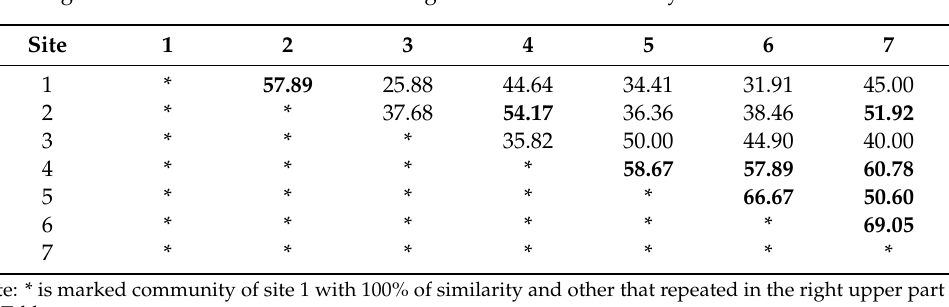
Figure 13. Canonical correspondence plots for algal communities in seven studied site of the Abraham Lincoln Birthplace National Historical Park at the division level and the environmental variables ( a ), and most abundant species, and environmental variables ( b ). Table 5. Similarity matrix for species richness of algae in the Abraham Lincoln Birthplace National Historical Park waterbodies. The abbreviations for the sites are the same as in Tables 1 and 2. The most similar algal communities with coe ffi cients larger than 50% of similarity are marked in bold.